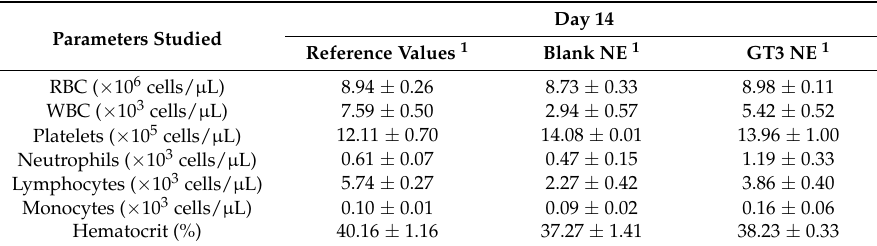
Figure 9. Body weights for CD2F1 mice following administration of NE with and without GT3 (600 mg/kg). Values are presented as mean ± standard deviation, n = 3. No significant differences in body weight measurements over time were detected within each treatment group. Table 1. Results of the complete blood count (CBC) Study.